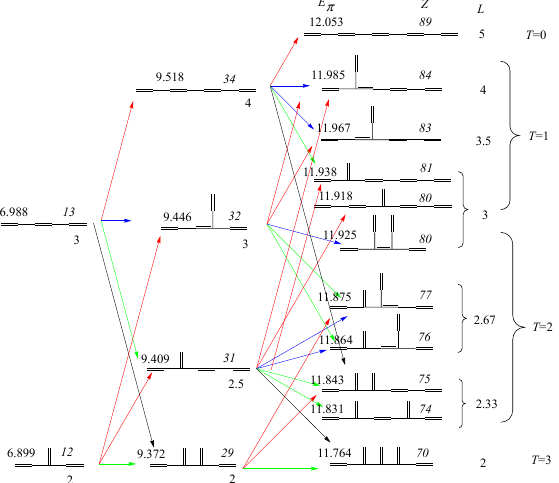
Figure 6. Genealogy of hexatrienes~decapentaene. Meaning of colors is the same as in Figure 4.